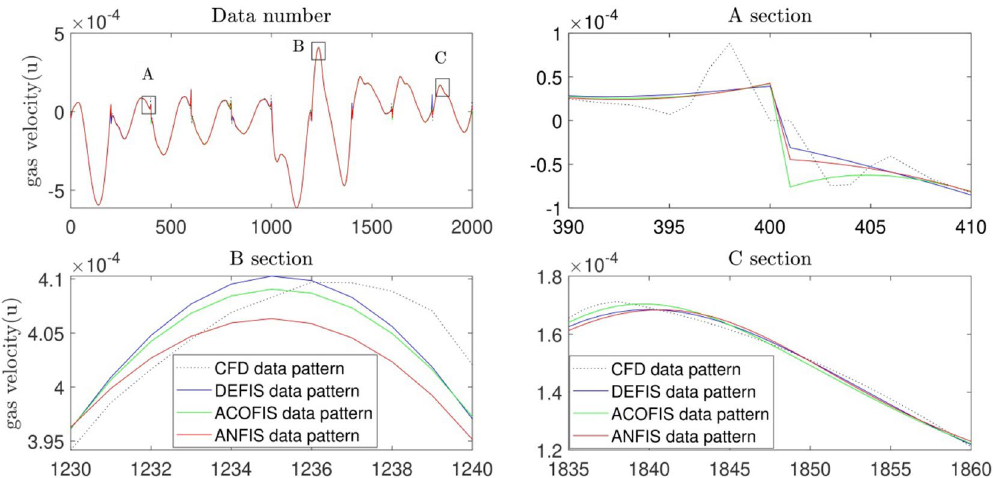
Figure 9. Pattern recognition for different methods such as ANFIS, DEFIS and ACOFIS.